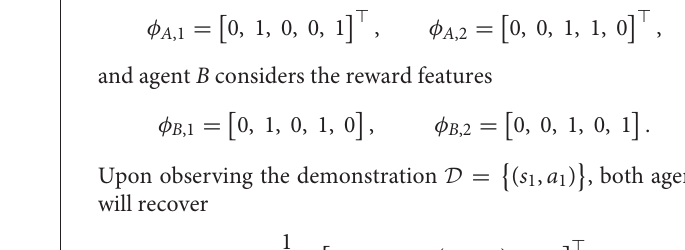
FIGURE 4 | Diagram representing an inverse reinforcement learning (IRL) agent. All transitions occur with probability 1. Transitions labeled with “ ∗ ” are associated with all actions a ∈ A